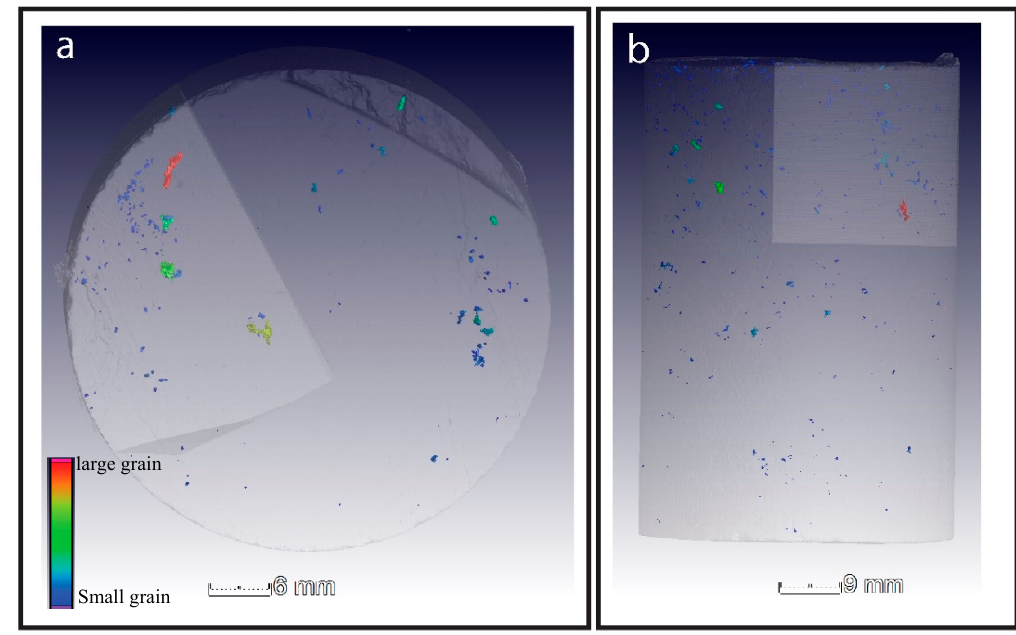
Figure 5. ( a , b ) Quarter cores that were sent for fire assay analysis cut from the whole cores. The grey colour in the drill core is the silicate matrix and other colours represent gold, distributed according to gold grain volume (warm colours = large grains, cold colours = smaller grains). Samples JJ01 and JJ02.